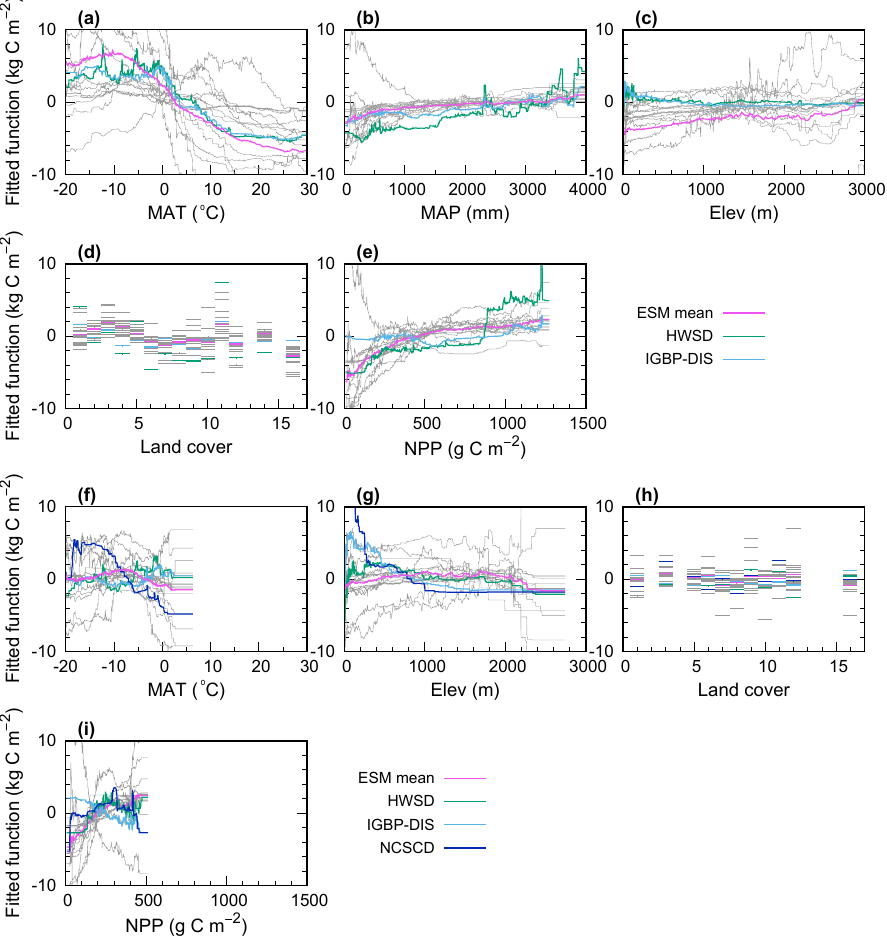
Figure 6. Effect of the most influential variables in the model for global (a–e) and northern (f–i) outputs from ESMs and a comparison with those of observational databases. Grey lines show the results of each ESM, and the purple line indicates the mean of the ESMs. The fitted functions were centered by subtracting their means. See Table A2 for land cover classifications. Because of the small number of data points, the results for “permanent snow and ice” are not shown (d, h)